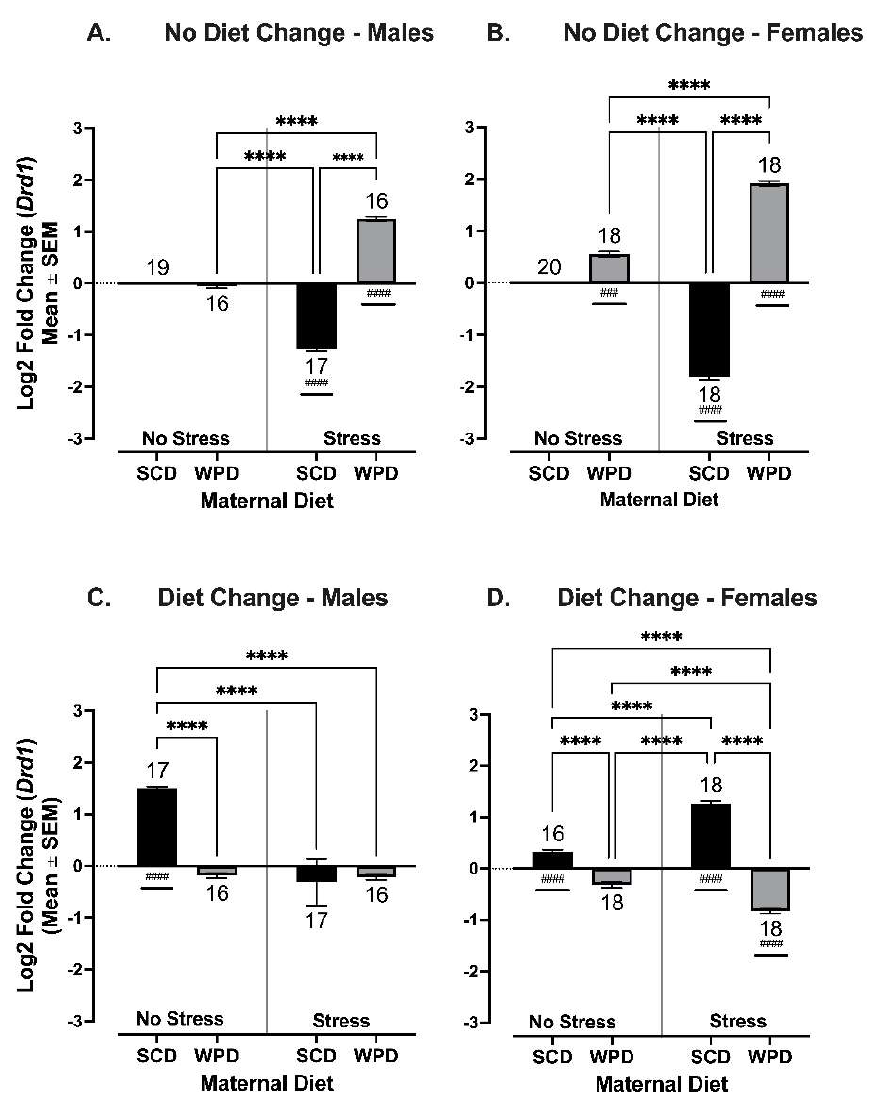
Figure 8. Drd1 log2 fold change in expression in Nacc compared to no stress/SCD fed controls for ( A ) males whose diets remained consistent at weaning, ( B ) females whose diets remained consistent at weaning, ( C ) males whose diets were switched at weaning, and ( D ) females whose diets were switched at weaning. Group n ’s located above/below bars. WPD = Western pattern diet, SCD = standard chow diet. **** p < 0.0001. #: significant fold change relative to control. ### p < 0.001, #### p <